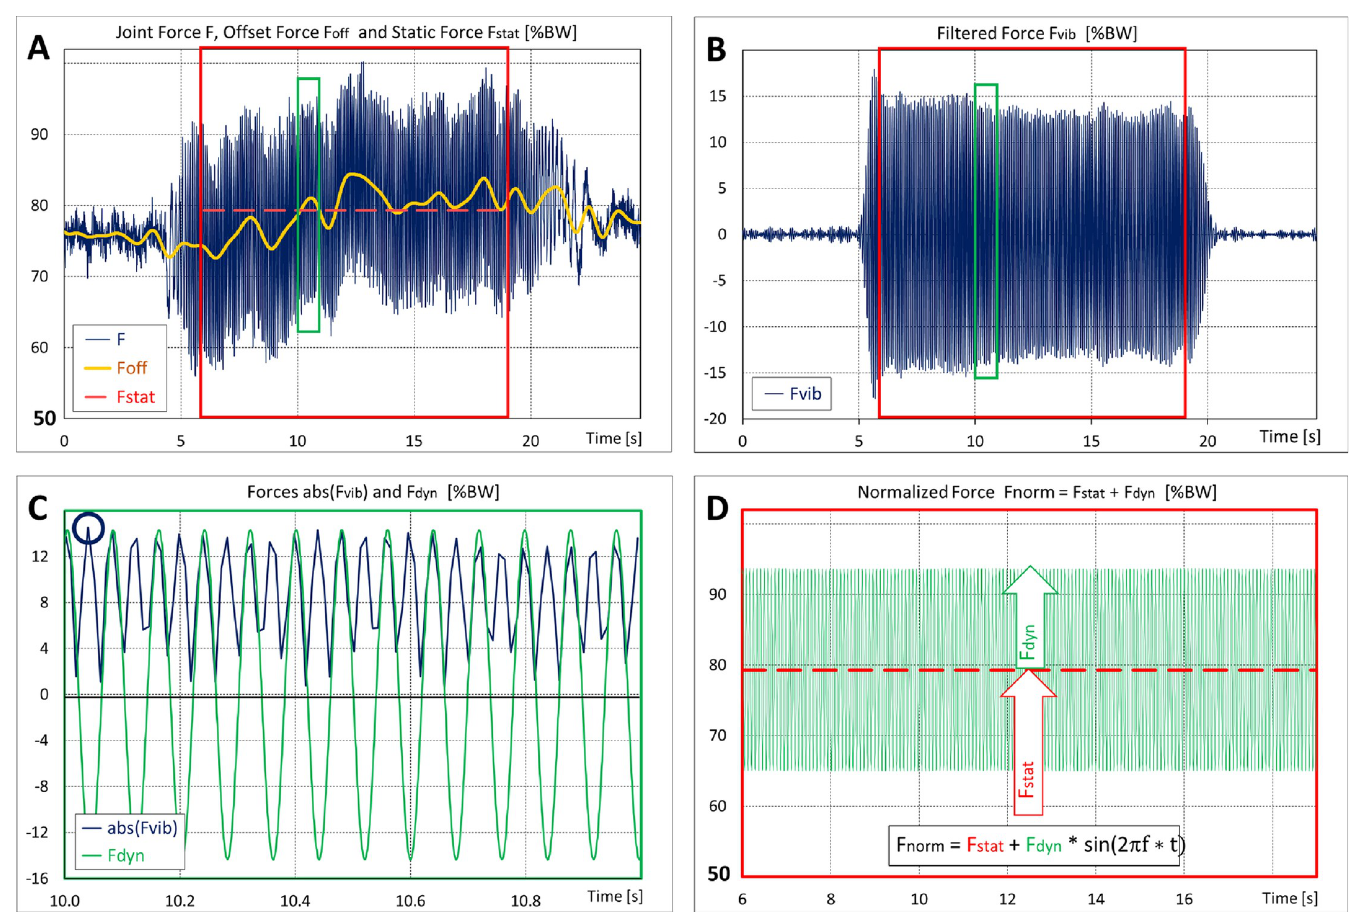
Fig 2. Measured contact force and data evaluation. Data from the preceding feasibility study. Galileo, knees 15˚ flexed, 12.5 Hz, 2.5mm. Vibrations between 4.5 s and 22 s. Evaluation range 6 s to 19 s (red frames). Note that the scales in A and D start at 50%BW. A : The joint force F consists of the offset force F off (yellow), the vibration component F vib around F off (blue) and small noise. F off is obtained by lowpass filtering of F. F stat (red) see explanation for D. B : Bandpass filtering of F eliminates F off plus noise and delivers F vib . C : Detail from the green boxes in A, B. F vib is rectified (abs(F vib ), blue). Every second, the maximum is determined (blue circle), and all maxima are averaged. This averaging delivers the amplitude F dyn of the dynamic force (green). D : Averaging of F off delivers the static preload F stat (dashed red). Reported are the median values and inter-individual ranges of F stat and F dyn of the ‘normalized’ joint force F norm = F stat + F dyn � sin(2 π f � t).